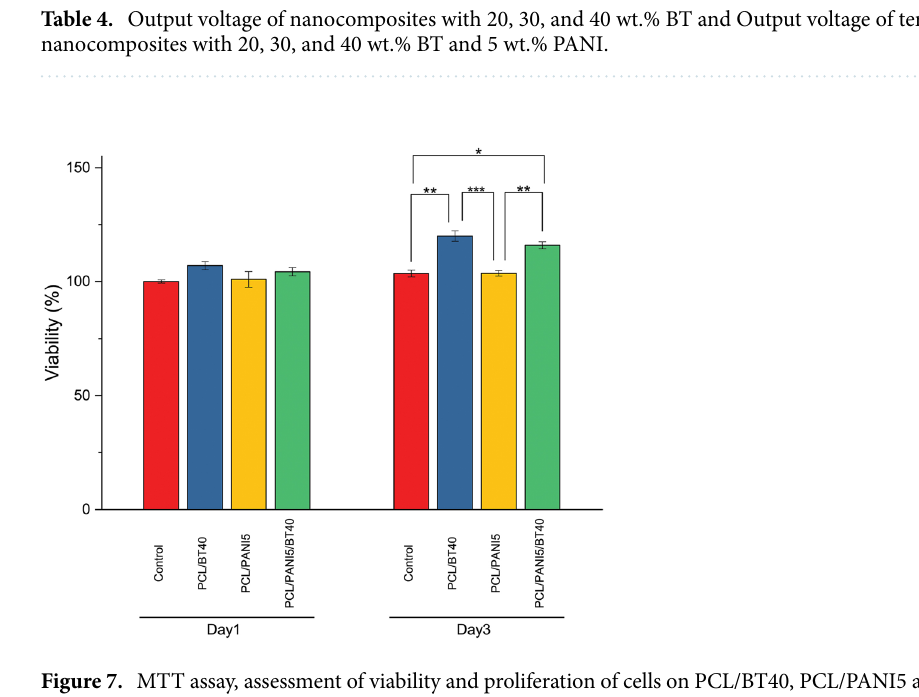
Figure 7. MTT assay, assessment of viability and proliferation of cells on PCL/BT40, PCL/PANI5 and PCL/ PANI5/BT40 nanofibers versus times. Results obtained for PCL/PANI5/BT40 sample as a piezo-electrical stimuli conductive nanocomposite showed that the scaffold is a surface-active platform for cells adhesion and growth via enhancing the cell growth and proliferation, where viability reached 104 ± 3% and 116 ± 2% on days 1 and 3,